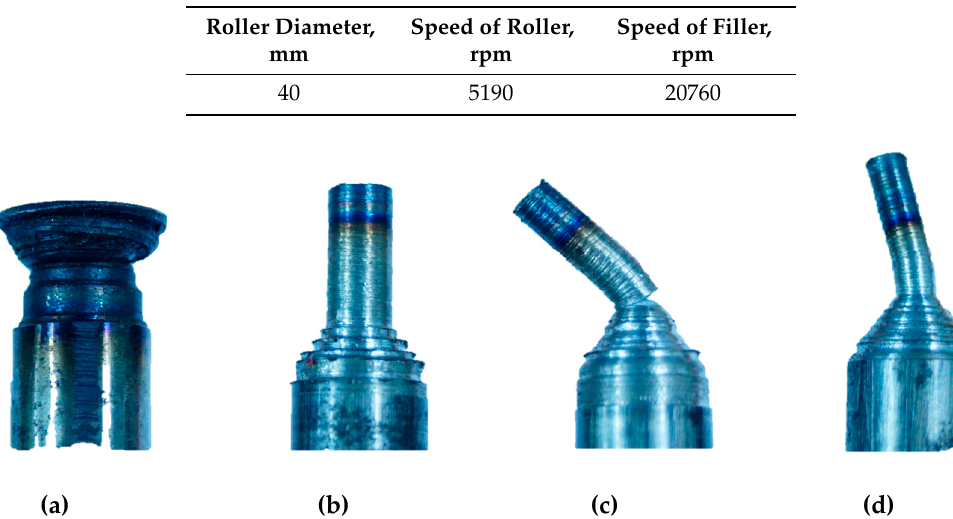
Table 3. The main parameters of the cladding device. Roller Diameter, Speed of Roller, mm